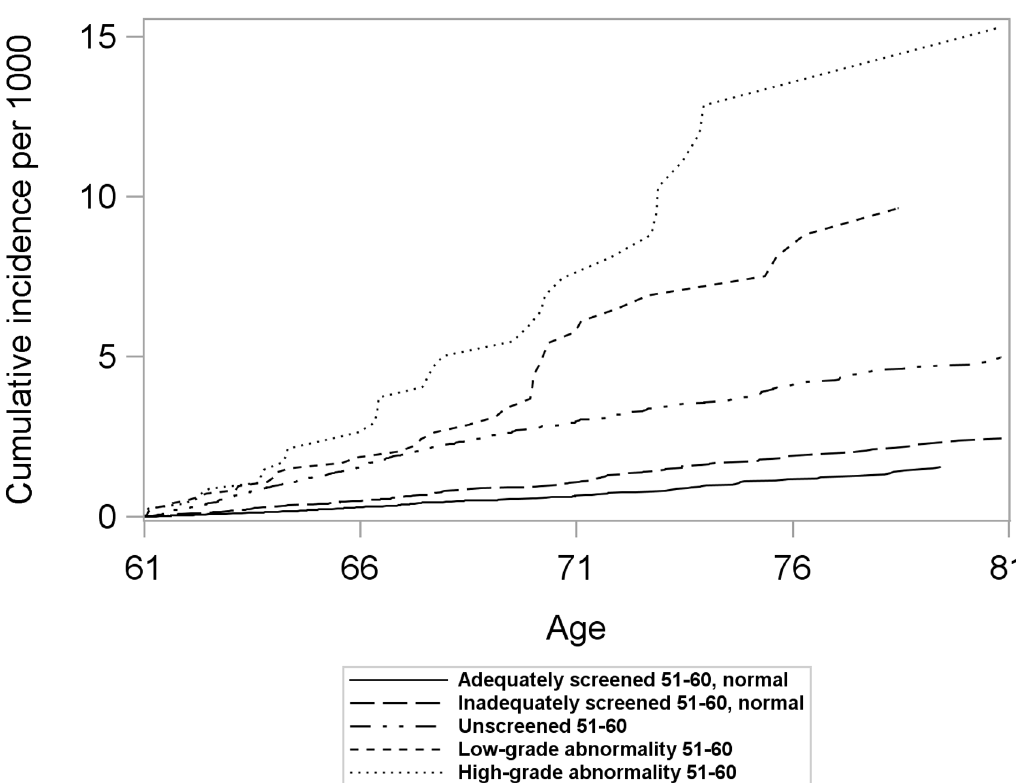
Fig 2. Cumulative incidence of cervicalcancer from age 61 to 80 by screening history at age 51–60 in women unscreened after age 60, considering death and total hysterectomy as competing events. Women screened after age 60 were censored at the time of their first Pap test after age